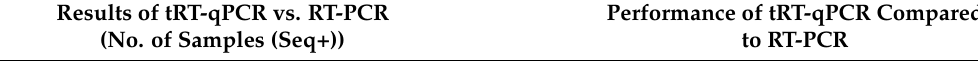
Table 4. Summary of the clinical performance of triplex RT-qPCR assay (tRT-qPCR) based on the comparison with previously published RT-PCR-based screening assays on n = 142 selected archived samples of swine. For the details of the comparisons, see Supplementary Table S2. Seq+: number of true-positive samples confirmed by